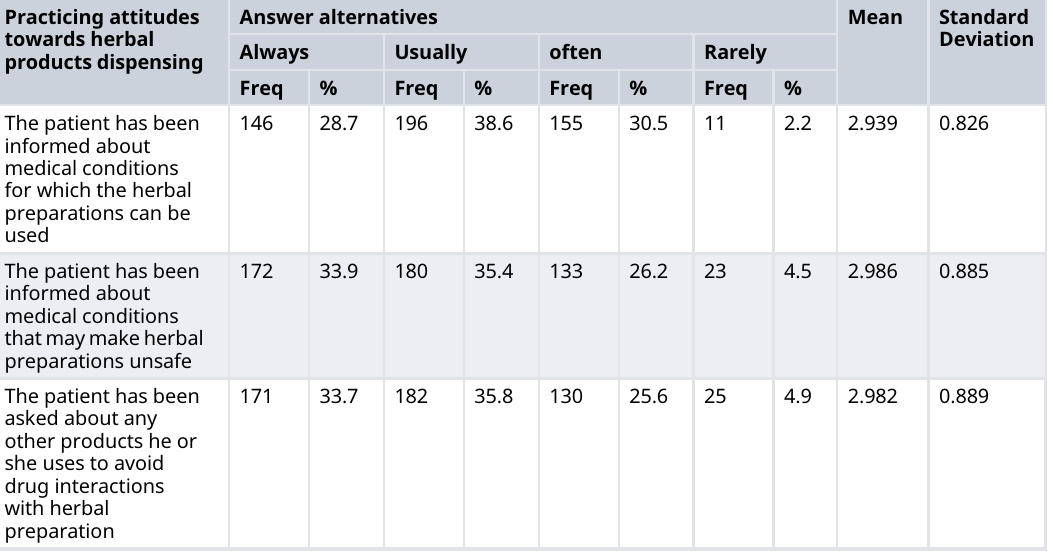
Table 3. Pharmacy practitioners ’ practicing attitudes towards herbal product dispensing in community pharmacies.